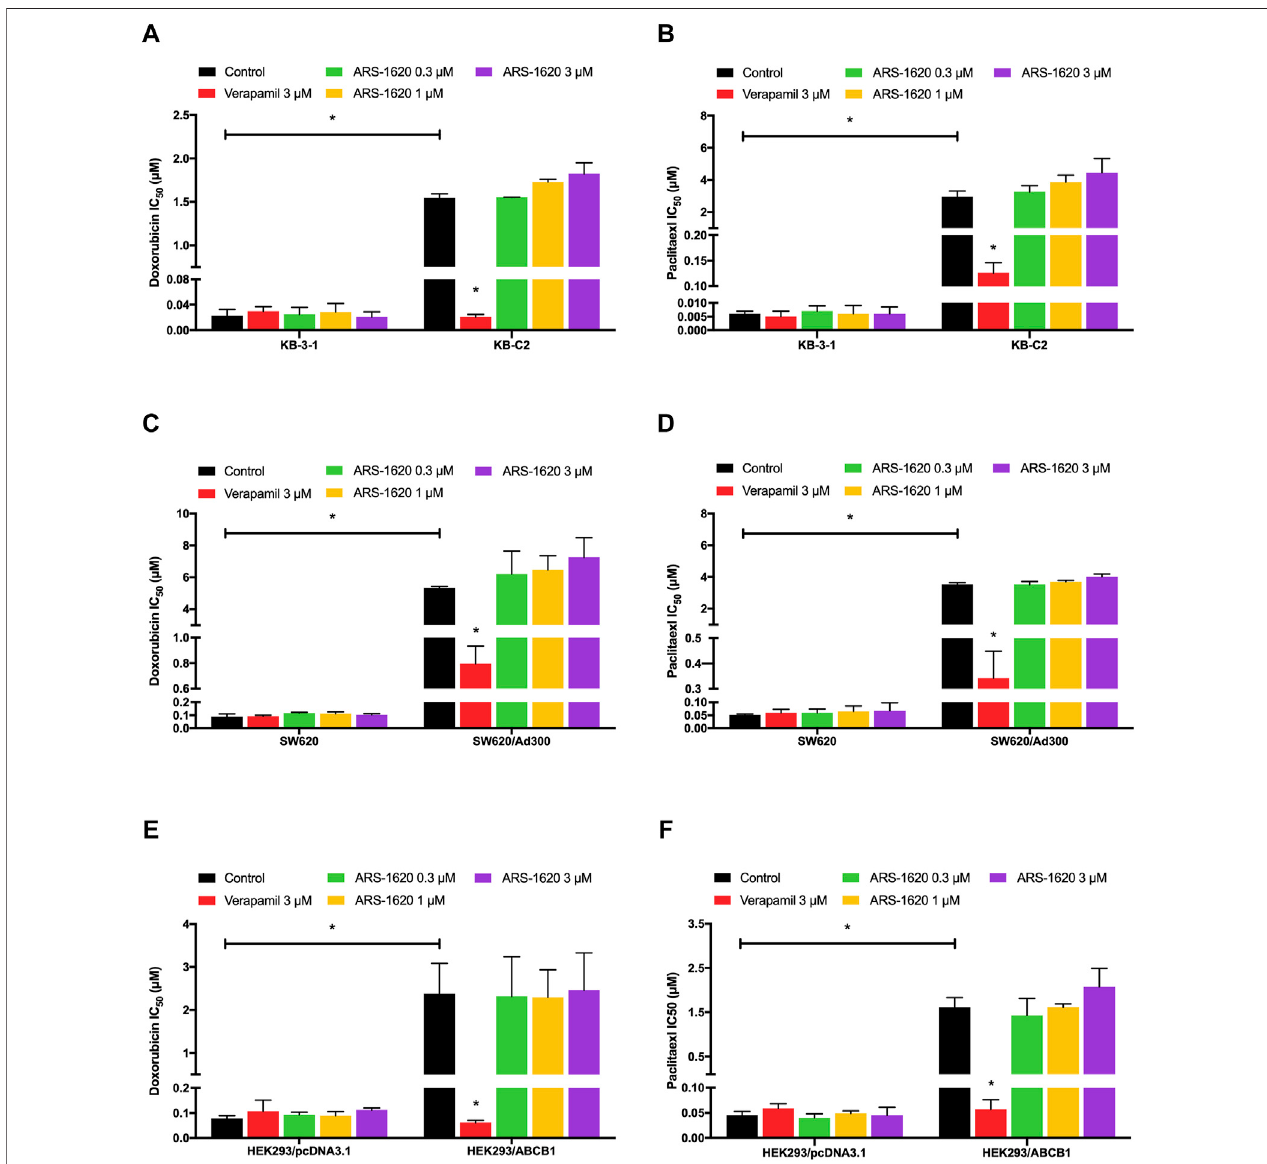
FIGURE 4 | Non-toxic concentrations of ARS-1620 were not able to reverse ABCB1-mediated MDR. In parental (A, C, E) and resistant (B, D, F) cell lines, ARS- 1620 (0.3, 1, 3 μ M) did not re-sensitize ABCB1-overexpressing cells to ABCB1 substrates (doxorubicin and paclitaxel) like verapamil, the positive control. * p < 0.05.